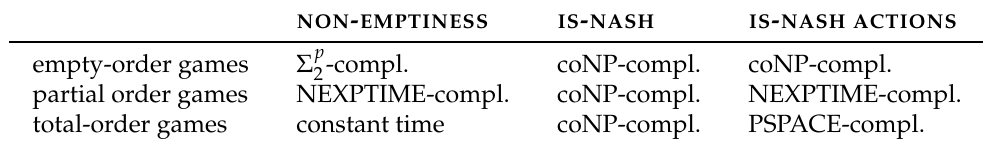
Table 1. Overview of complexity results surrounding Nash equilibrium in partial order games. NON - EMPTINESS IS - NASH IS - NASH ACTIONS empty-order games Σ p -compl. coNP-compl. coNP-compl. 2 partial order games NEXPTIME-compl. coNP-compl. NEXPTIME-compl. total-order games constant time coNP-compl.